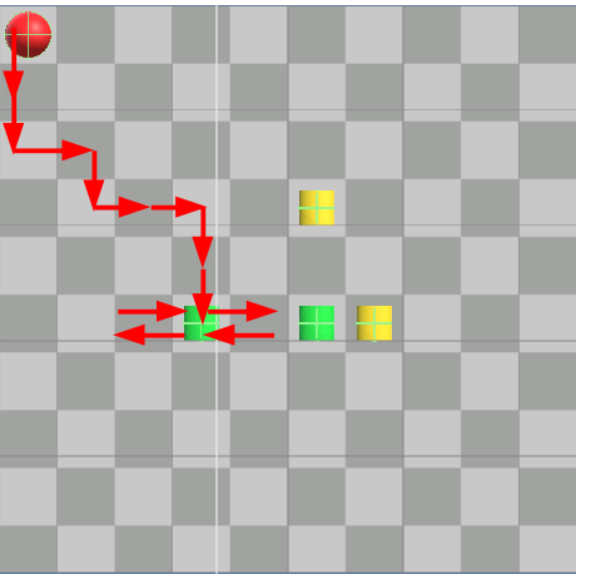
Figure 8. An example of a trajectory obtained in an execution of the grid world agent with the standard A3C algorithm.